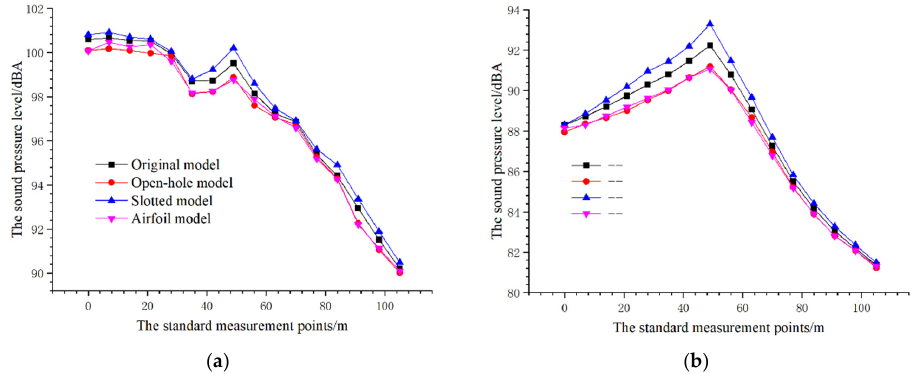
Figure 10. The sound pressure level distribution curves. ( a ) Complete vehicle. ( b ) Pantograph.